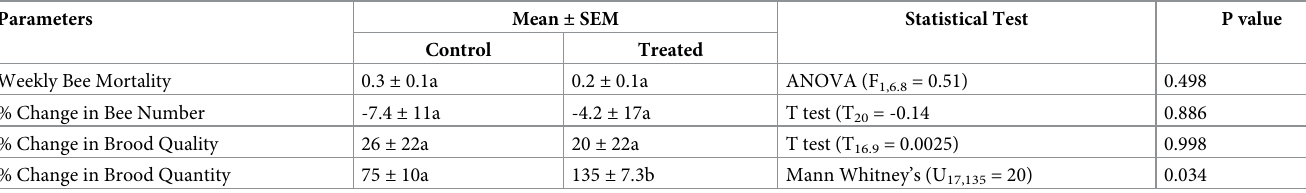
Weekly bee mortality (Mean ± SEM) was measured throughout the seven week study. Colony health (number of bees, brood quantity, and brood quality) is expressed as percentage change (Mean ± SEM) based on measurements at the beginning and at the end of the seven week study period. Significant differences between treated and untreated colonies are indicated by different